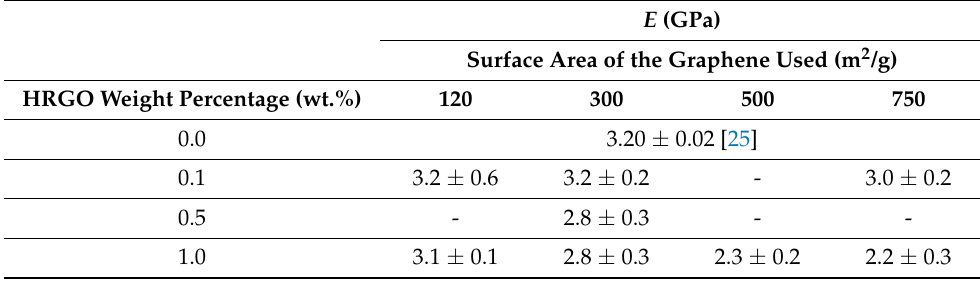
Table 9. Fracture toughness, K IC , of the material versus the percentage and surface area of the added HRGO. Each result shows the mean value and root mean square error. K IC (MPa · m 1/2 ) Surface Area of the Graphene Used (m 2 /g) HRGO Weight Percentage